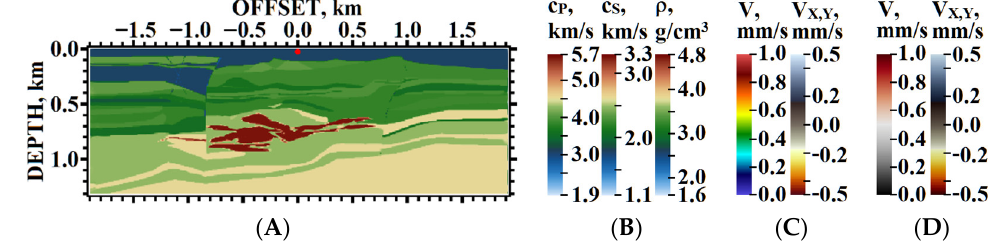
Figure 31. Example #5: ( A ) geophysical model, «without fractures», the point source is marked by the red dot; ( B ) scales of elastic properties; ( C ) scales of wave field snapshots; ( D ) scales of seismo- grams.